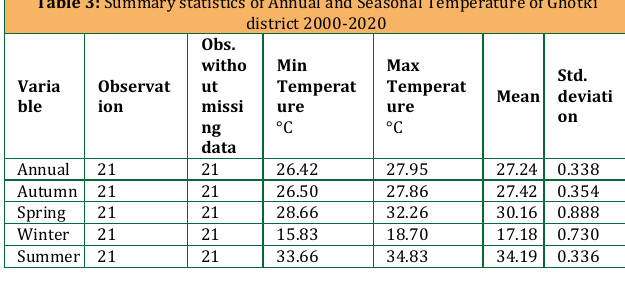
Table 4: Illustrate temperature (annual average, winter, spring, summer, and autumn) for the year 2000-2020 Paramet ers